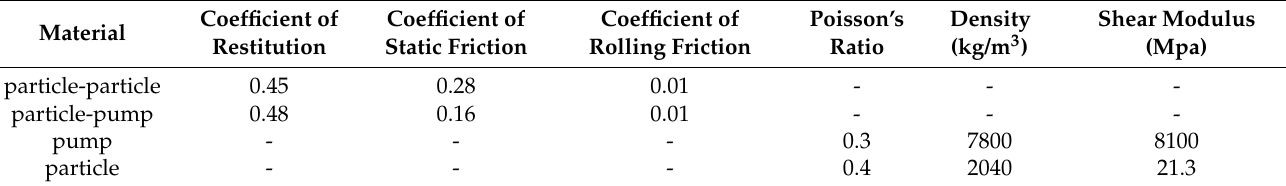
Table 2. Setting of particle parameters and wall parameters.